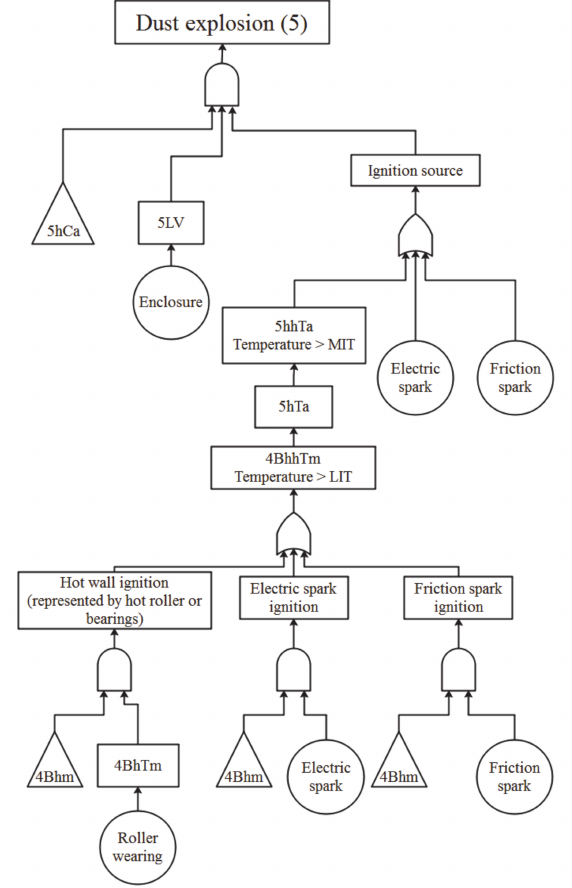
Figure 6. Fault tree for the dust explosion top event. 5hCa—high concentration inside node 5; 5hhTa— very high air temperature inside node 5; 4BhhTm—very high temperature of mechanical parts inside node